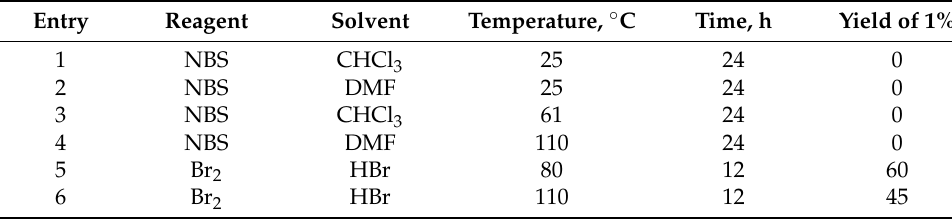
Table 1. Bromination of benzo[1,2- d :4,5- d ′ ]bis([1,2,3]thiadiazole) 3 .